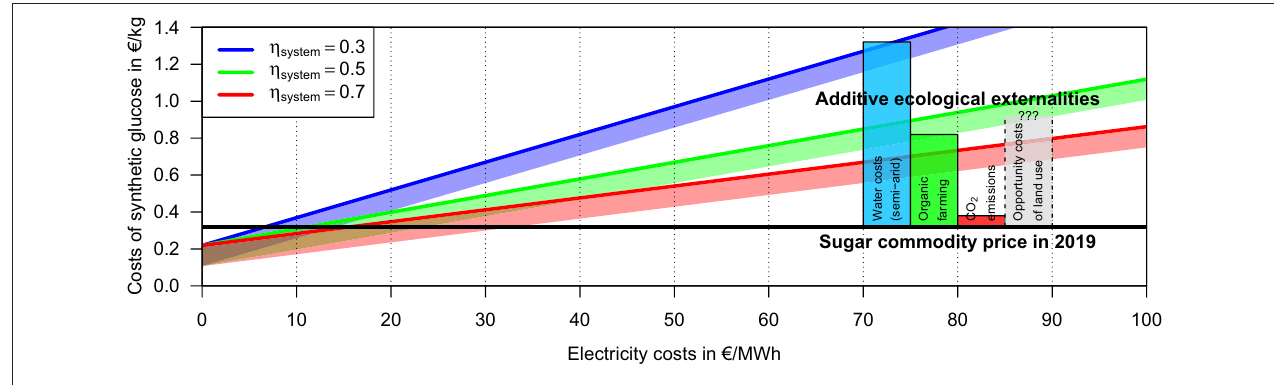
FIGURE 3 | Estimated production costs of 1 kg synthetic glucose—exclusive the potentially non-negligible costs for the targeted hexose stereoisomer production—dependent on the electricity costs (x-axis), the non-material costs (intercept with the y-axis), and the system efficiency of the glucose synthesis plant (lines of different color). The thick colored lines indicate the expected costs for commercialized or soon commercialized technology summarized in the Tables 1 , 2 . The shaded polygons indicate the corresponding cost ranges when the non-material costs are further reduced down to the estimates by Graves et al. (2011). On the right side of the figure, the market price of conventional sugar and the lower estimates for costs of the ecological externalities of the conventional sugar production are indicated (see Table 3 ). The opportunity costs of the land use are added for qualitative completeness but its quantitative range has to been estimated.